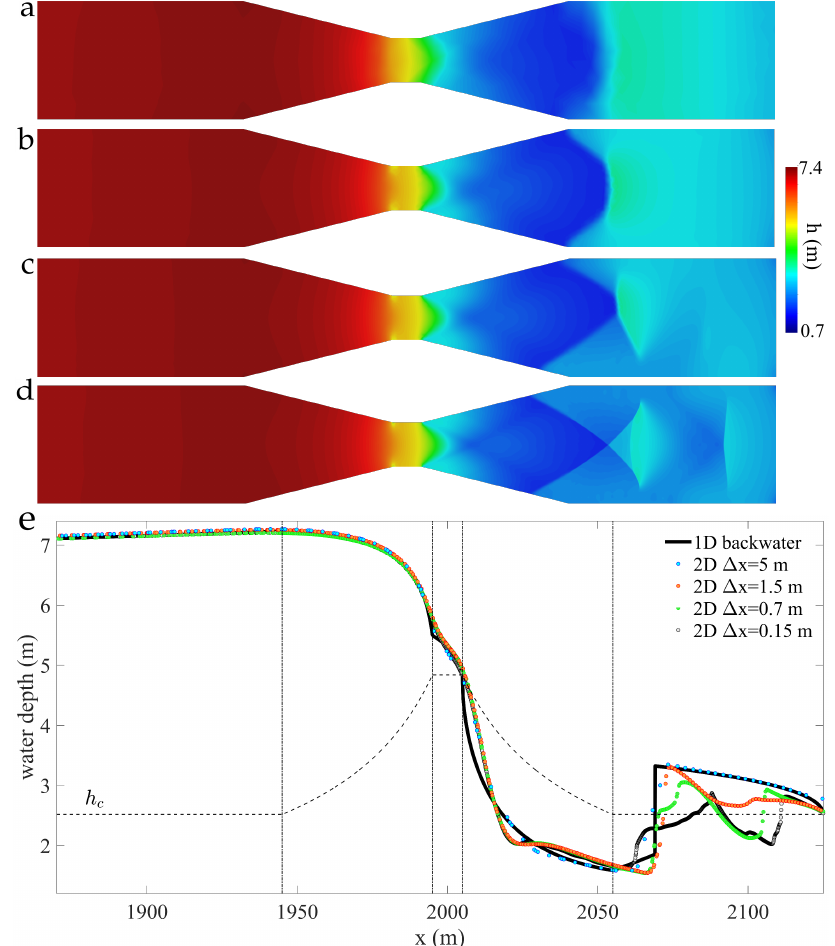
Figure 17. Impact of grid refinement on 2D shallow-water simulations of transcritical flow. We show maps of water depth computed using different grid sizes in the contraction region, ∆ x = 5,1.5,1,0.15 m (panels a – d respectively). The length of the expansion zone is L e = 50 m and the distance to the outlet is L d = 125 m. The coarse grid solution agrees with the water profile computed using the classical 1D theory (panel e ). As the grid is refined, and the simulations capture the complex 2D flow features, the 1D and 2D predictions deviate significantly. In particular, the sharp hydraulic jump of the 1D theory is replaced by an intricate sequence of oblique standing waves (panel d